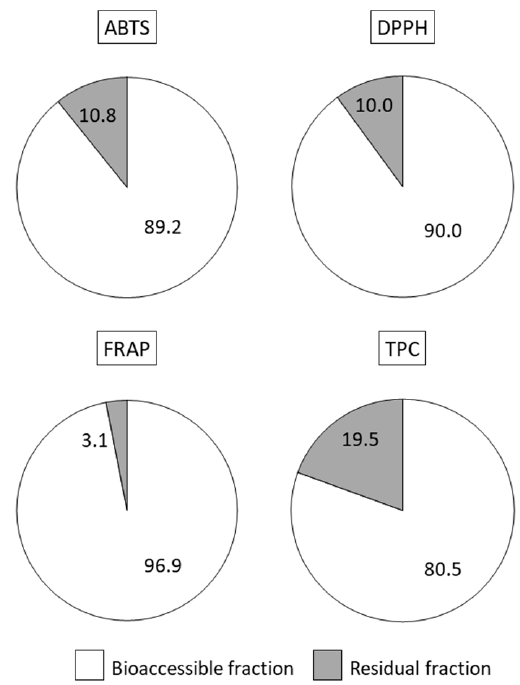
Figure 3. Contribution of the bioaccessible and residual fractions (%) to the total ABTS, DPPH, FRAP and total polyphenols (TPC) recovered after in vitro digestion of the whey beverage ( Colada ). Usually, antioxidant properties are measured in vitro by the ability to transfer hydrogen atoms or electrons to an oxidant, and ABTS, DPPH and FRAP methods are commonly applied with this aim. However, the use of cell model systems, such as the Caco-2 intestinal cell line, is recommendable to better assess the in vivo antioxidant potential of dietary compounds [37]. Preincubating Caco-2 cells for 2 h with the BF of the Colada beverage significantly reduced ROS generation in basal conditions (Figure 4A). In addition, a protective effect against induced oxidative stress (25% of decrease in ROS production) was observed (Figure 2B), supporting the antioxidant activity of the Colada digest at the cell level.